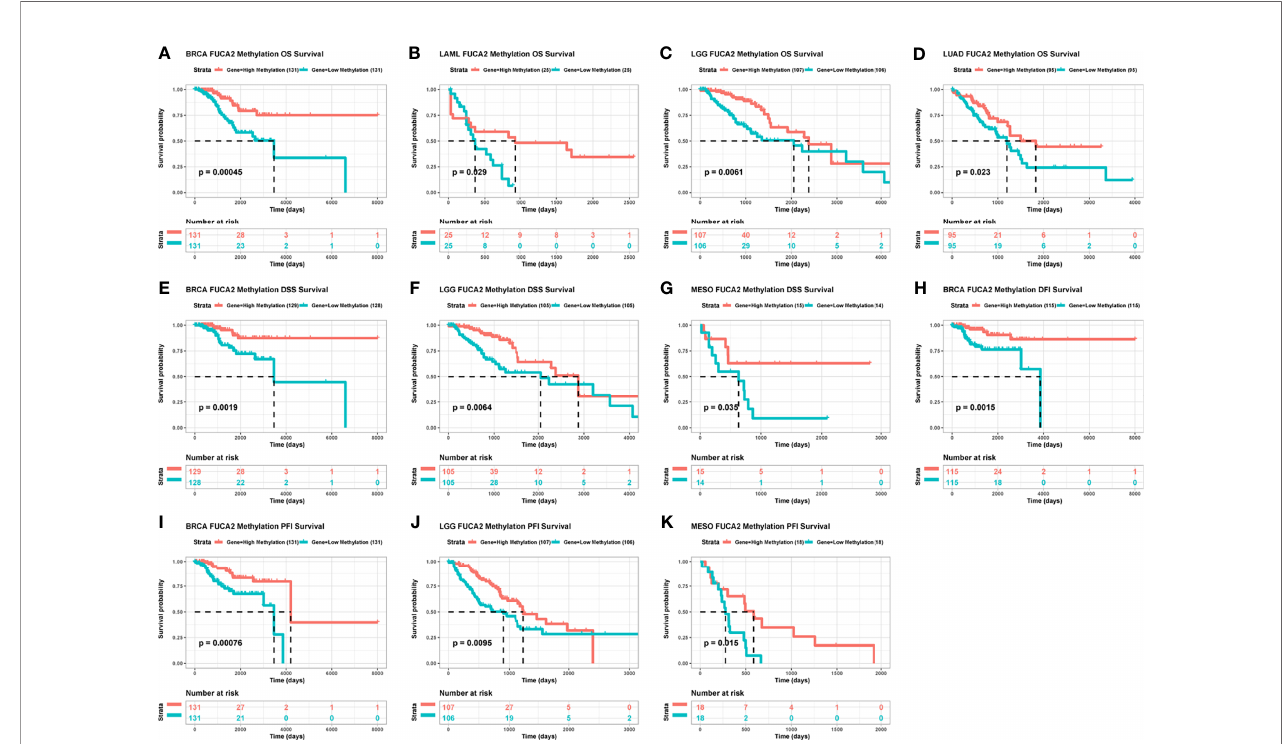
FIGURE 6 | Correlation between FUCA2 methylation and survival of tumor patients. (A – D) Correlation between FUCA2 methylation and OS in BRCA, LAML, LGG and LUAD. (E – G) Correlation between FUCA2 methylation and DFS in BRCA, LGG and MESO. (H) Correlation between FUCA2 methylation and DFI in BRCA. (I – K) Correlation between FUCA2 methylation and PFI in BRCA, LGG, and MESO. Only signi fi cant results were